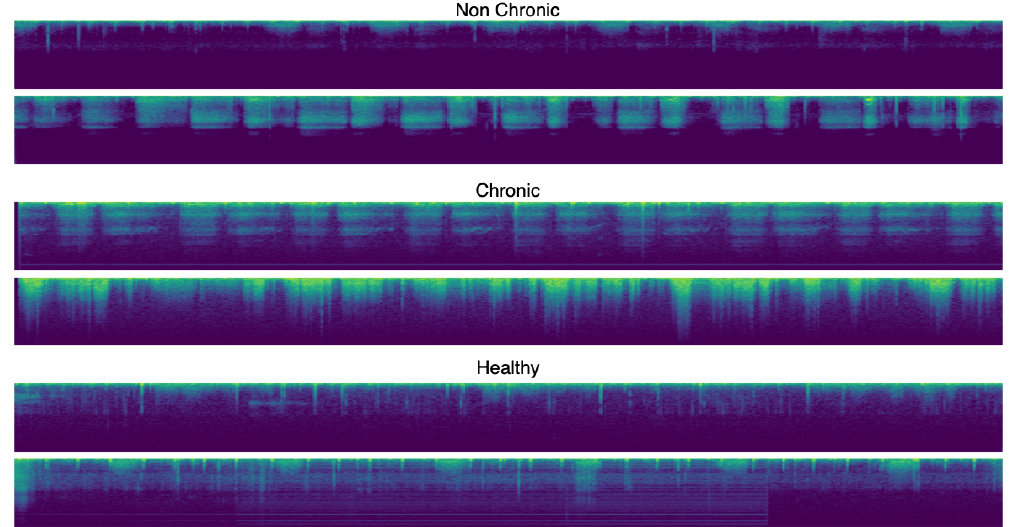
Figure 4. Examples of the Mel Spectrograms for the chronic, non-chronic and healthy classes after preprocessing.